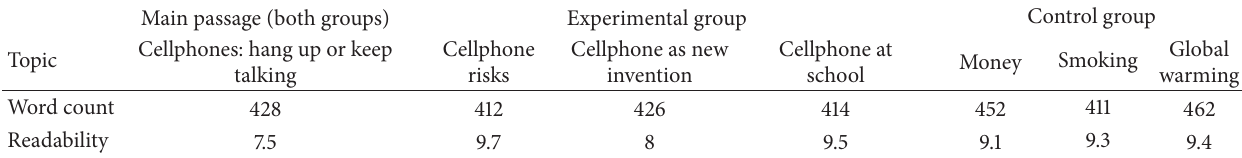
Table 1: Readability and word count of the